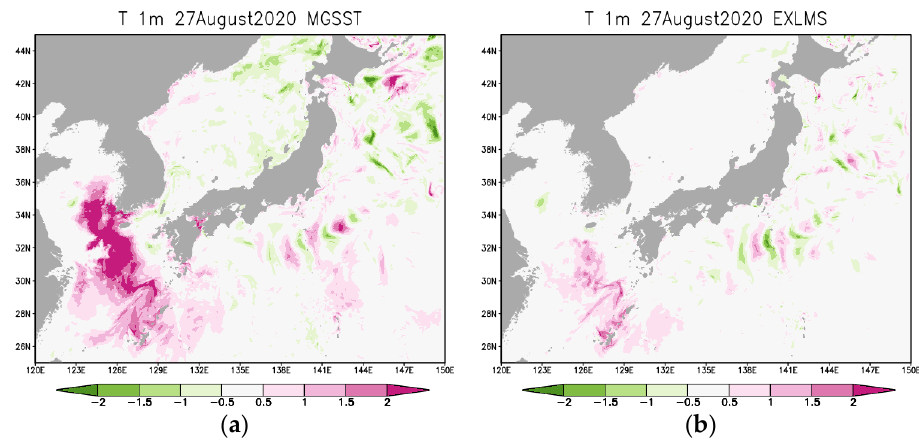
Figure 9. Difference in SST between the MGSST ( a ) EXLMS ( b ) and BASEX cases on 27 August 2020. Table 7. Mean difference (in °C) in the ECS region (see Figure 1 for the location) between modeled and observed SST (the merged satellite SST) data the period from August 25 to 31, 2020. Cases BIAS BASEX 0.00 MGSST 0.62 EXLMS